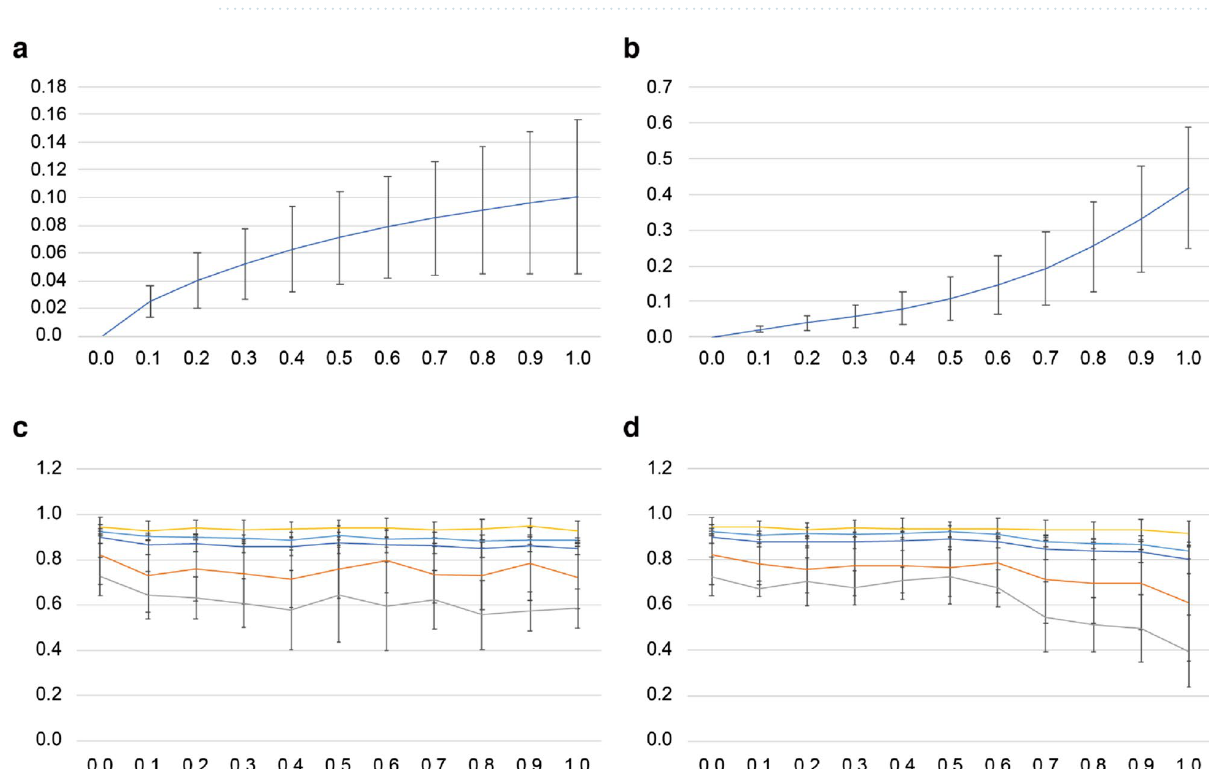
Figure 4. Assessment of the robustness of deep radiomics. Each perturbation such as pixel intensity scale and shift was applied to input images with the magnitudes in the range between 0.0 and 1.0 in increments of 0.1. ( a ) Difference ratio according to pixel intensity scale. ( b ) Difference ratio according to pixel intensity shift. ( c ) Classification performances (accuracy: blue, precision: orange, recall (sensitivity): gray, specificity: yellow, and negative predictive value: light blue) according to pixel intensity scale. ( d ) The same classification performances according to pixel intensity shift. See the performance degradation owing to the pixel intensity shift worsened when the magnitude exceeds more than 0.6. For all the data points, mean ± standard deviation is